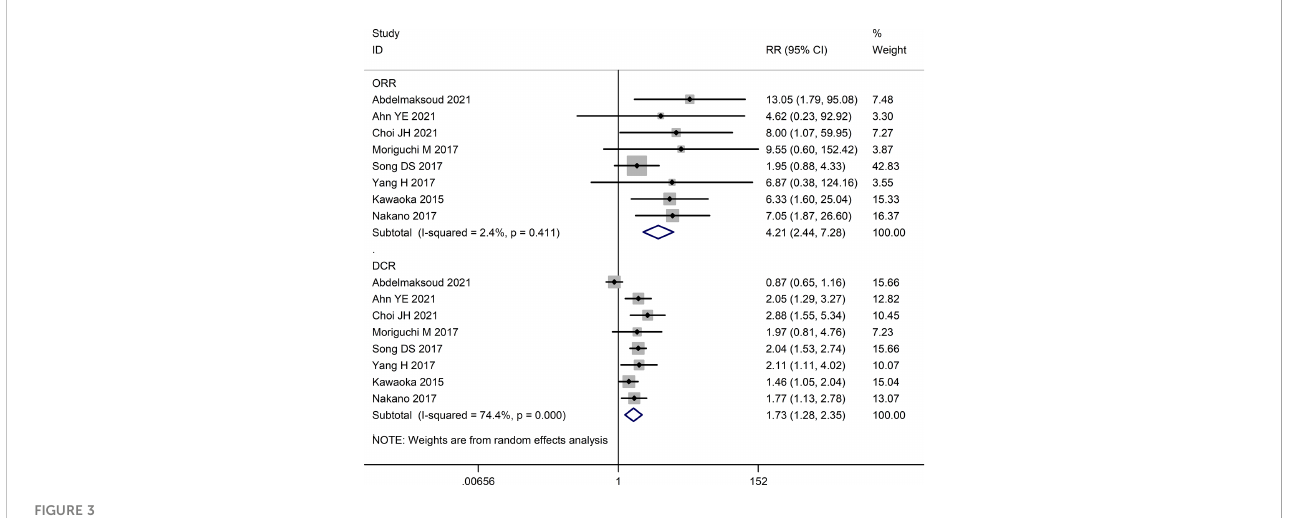
FIGURE 3 Forest map of objective response rate (ORR) and disease control rate (DCR) .